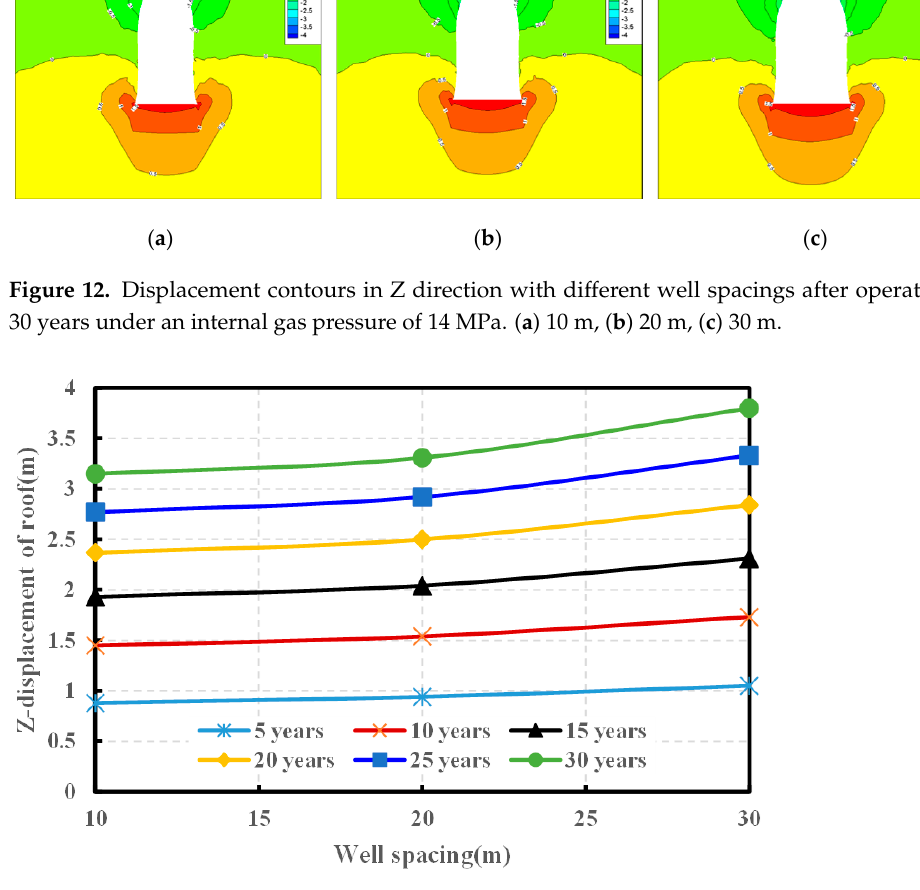
( c ) Figure 14. Displacement contours in X direction with different well spacings after operating for 30 years under an internal gas pressure of 14 MPa. ( a ) 10 m, ( b ) 20 m, ( c ) 30 m.